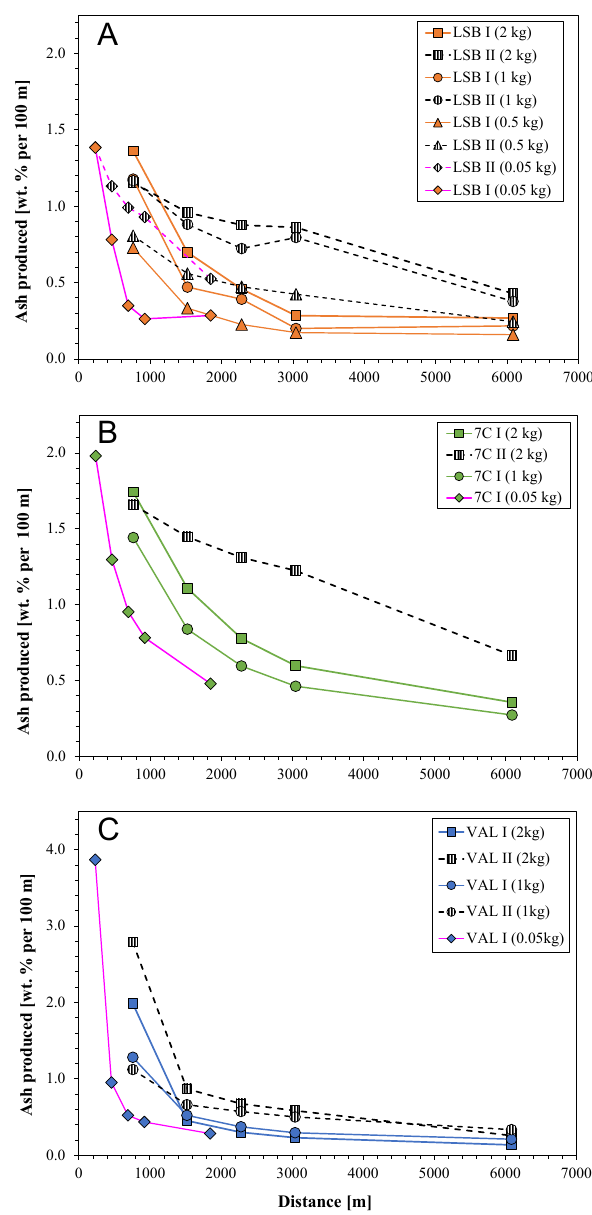
Figure 4: Change in rate of ash production during tumbling experiments. The evolution of ash produc- tion rate with increasing tumbling distance is shown for [A] Laacher See pumice (LSB); [B] Sete Cidades pumice (7C) and [C] Valentano scoria. Symbols, lines and colours are the same as for Figure 3. The data are plotted for each tumbling segment as the average weight fraction of ash produced per 100 m rotational distance in that segment. The mass was measured at the start and end of each experimental segment for each experimental protocol (type I and II, indicated by line dashes while symbols and line thickness identify the initial mass of the starting